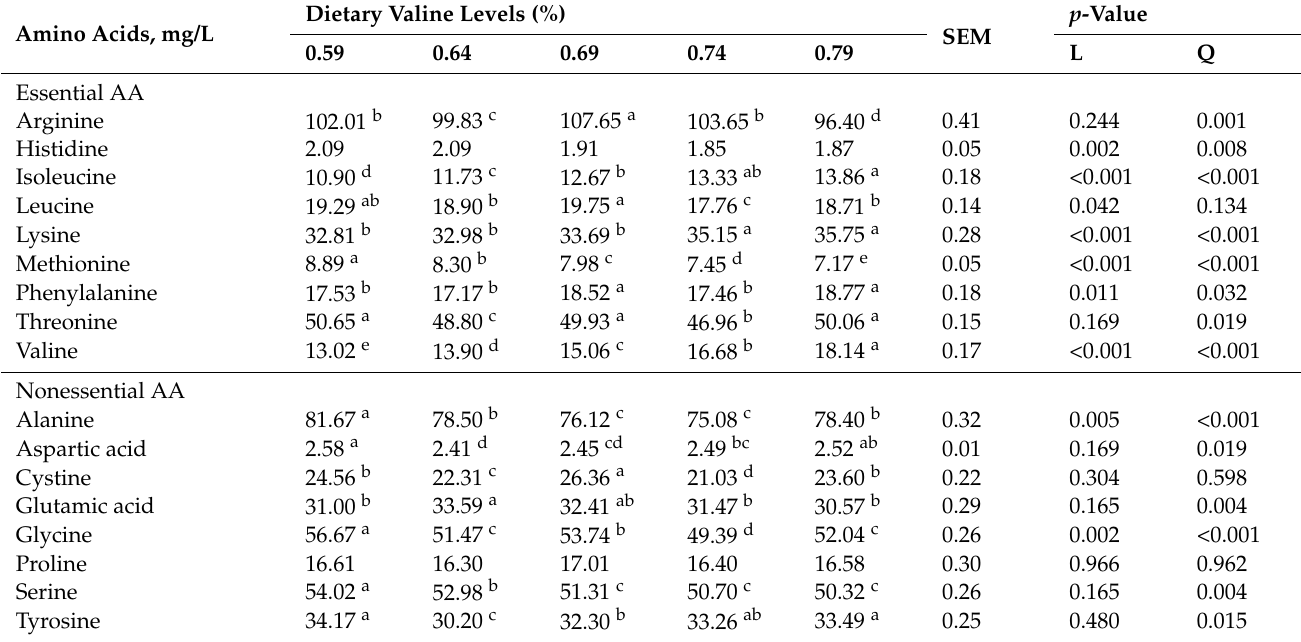
Values are represented as the mean and SEM (n = 4). Means with different superscript letters (a–e) within a column differ significantly ( p <